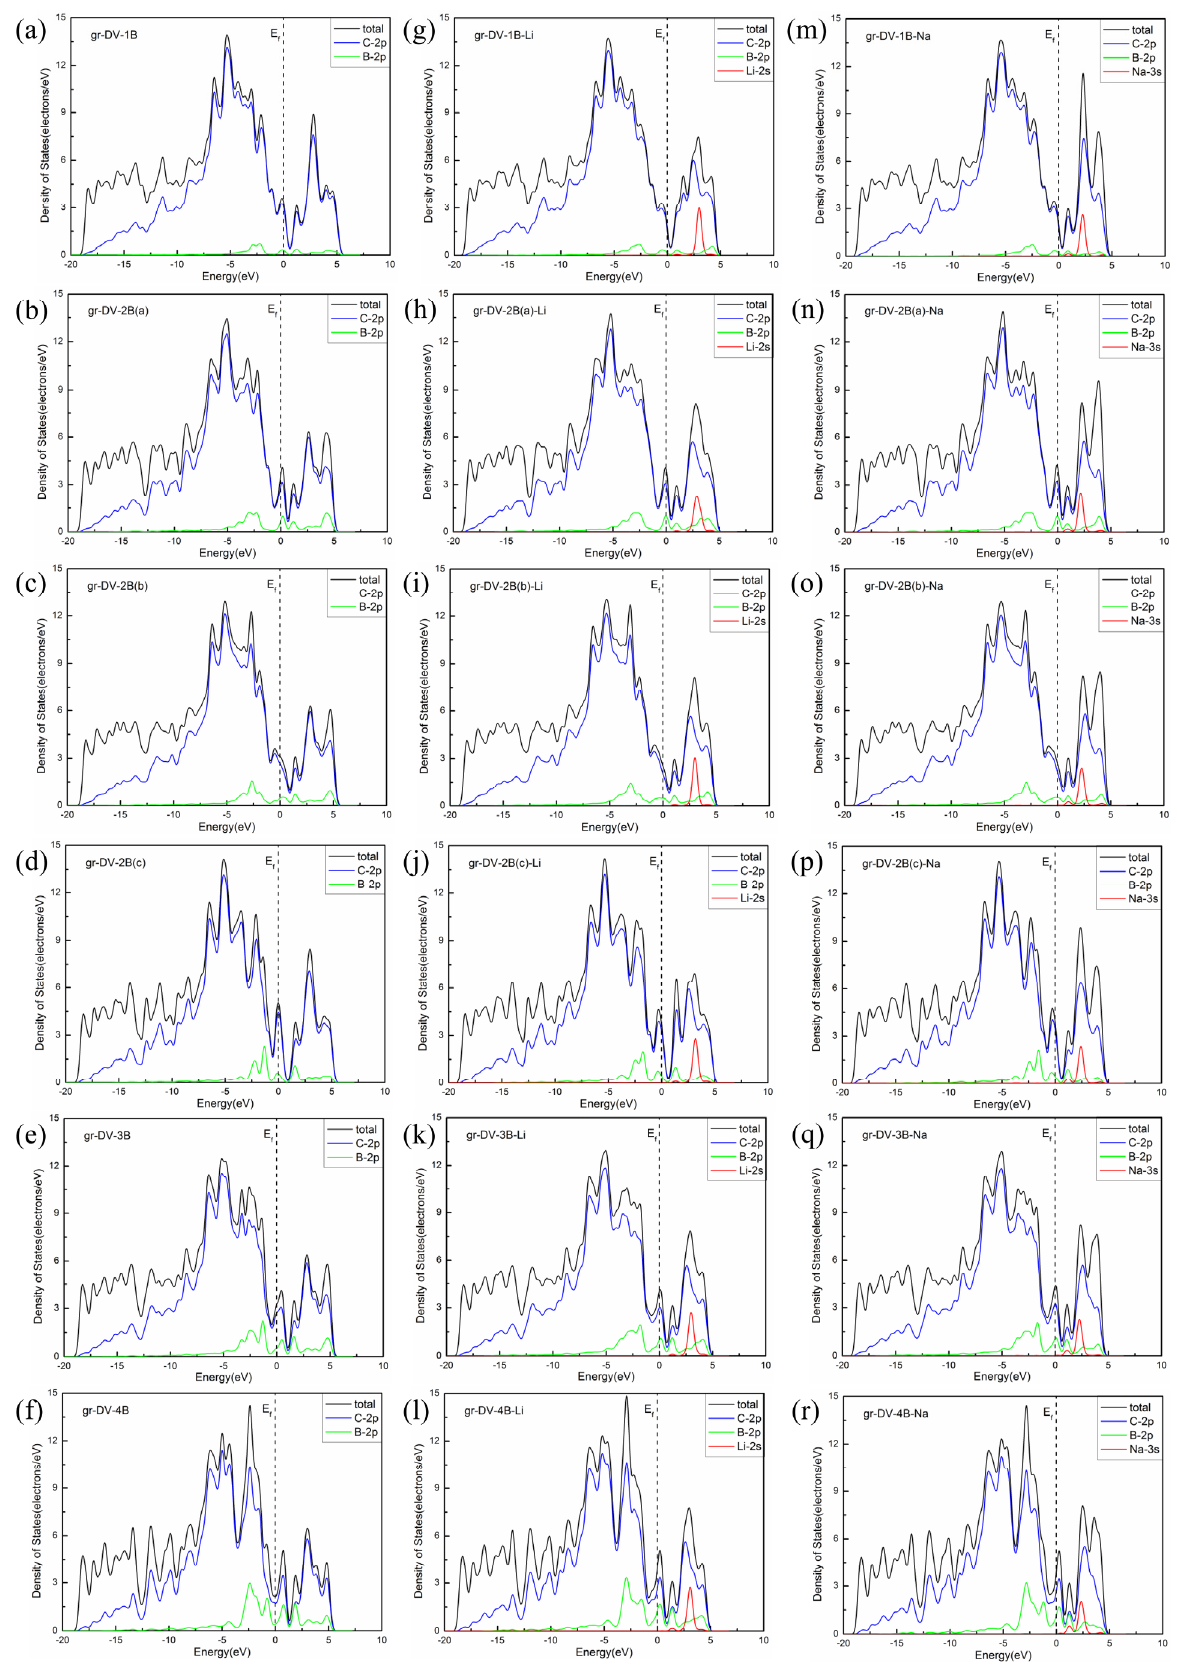
Figure 7. Density of states for graphene with DV doped by: ( a – f ) one to four B; ( g – l ) one to four B with Li; and ( m – r ) one to four B with Na.